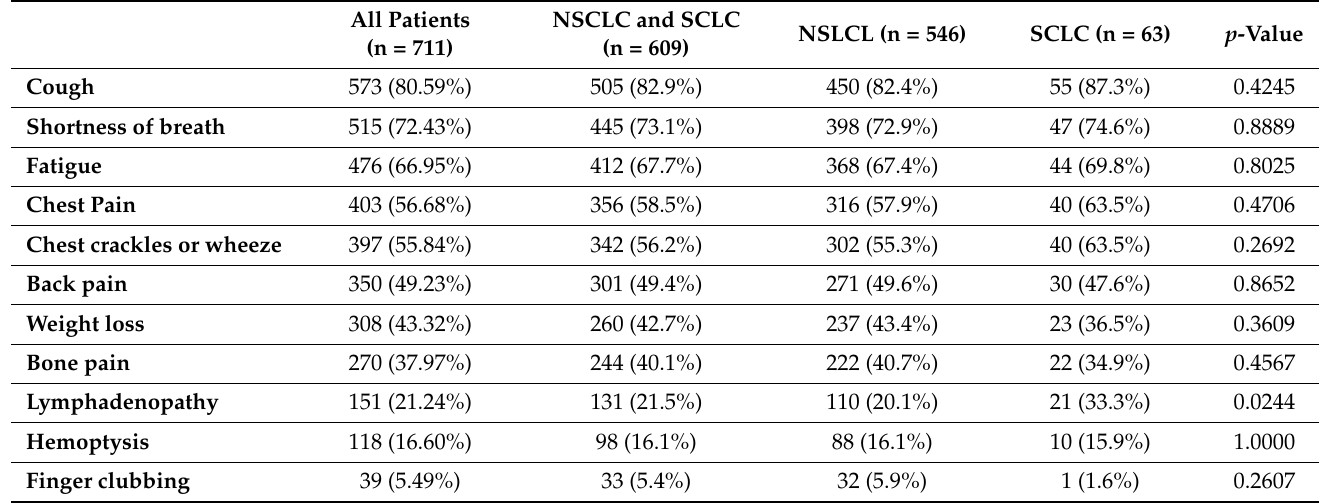
Table A5. Comparison of frequency of clinical features in the 2 years prior to diagnosis between NSCLC and